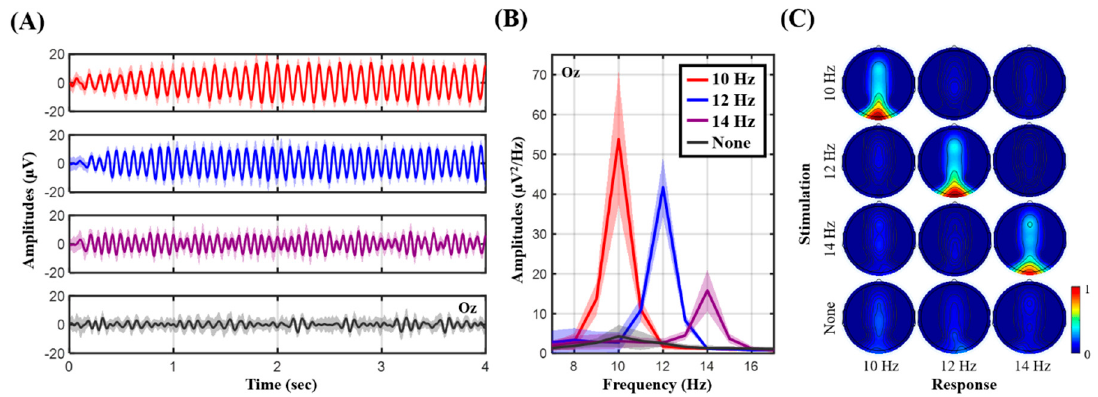
Figure 4. The SSVEP outcomes corresponding to frequency-coded visual flickers against fixation cross. ( A ) Temporal profiles of Oz from a representative subject; ( B ) spectral profiles of Oz from the same representative subject; ( C ) averaged 8-ch topographic mapping of SSVEP SNR using 4-s trials by 15 participants.